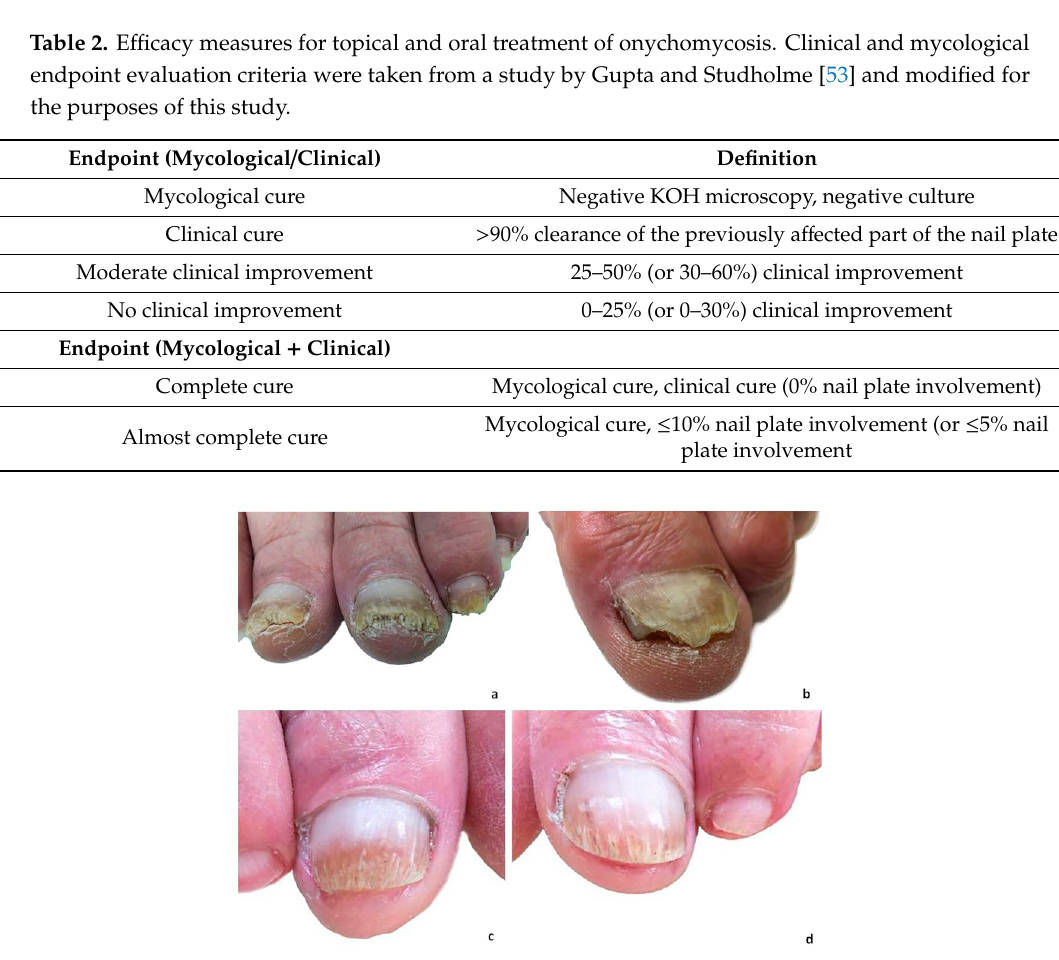
Figure 7. Examples of the therapeutic effect of NTP in combination with nail hygiene in vivo: ( a ) Big toenails of both feet with onychomycosis ( T. rubrum ) before NTP application, hyperkeratosis of the distal parts of the nail plates with crumbling, growth of the healthy parts proximally about 3–4 mm, other toenails also distally affected by onychomycosis to varying extents. ( b ) A big toenail with onychomycosis ( T. interdigitale ) before NTP application; the uneven distal part of the nail plate shows signs of hyperkeratosis and fungal appearance; there are signs of cleft on the medial side of the nail plate. ( c,d ) The big toenails of both feet at six months from the first NTP application with no hyperkeratosis of the distal parts; microscopy and culture of the nail samples were negative.